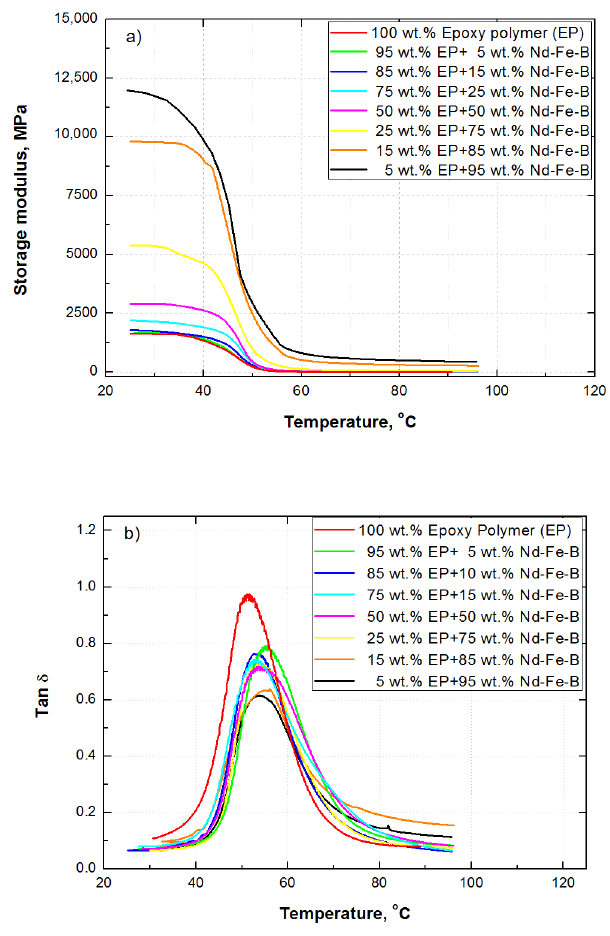
Figure 7. DMA curves of composites and pure epoxy resin, ( a ) Storage modulus and ( b ) Tan δ vs. temperature.